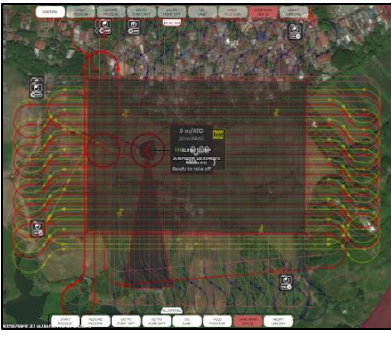
Figure 3. Flight path represented in red lines